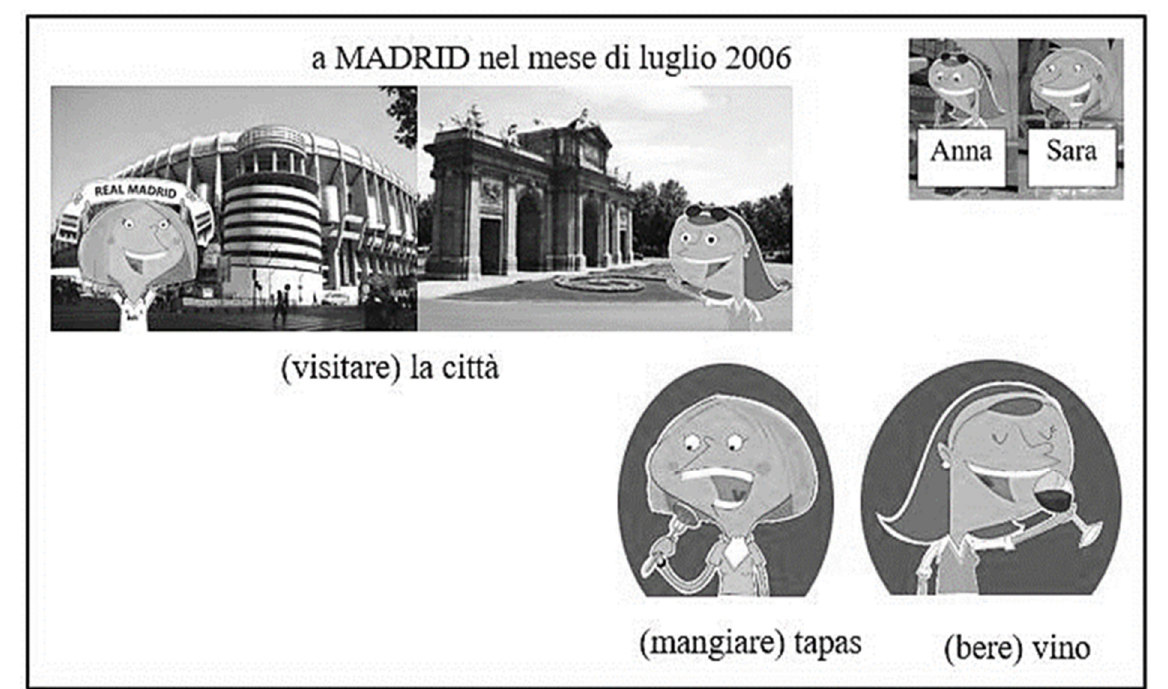
Figure A1. Example of Perfective Context from the “Sisters’ Story”.